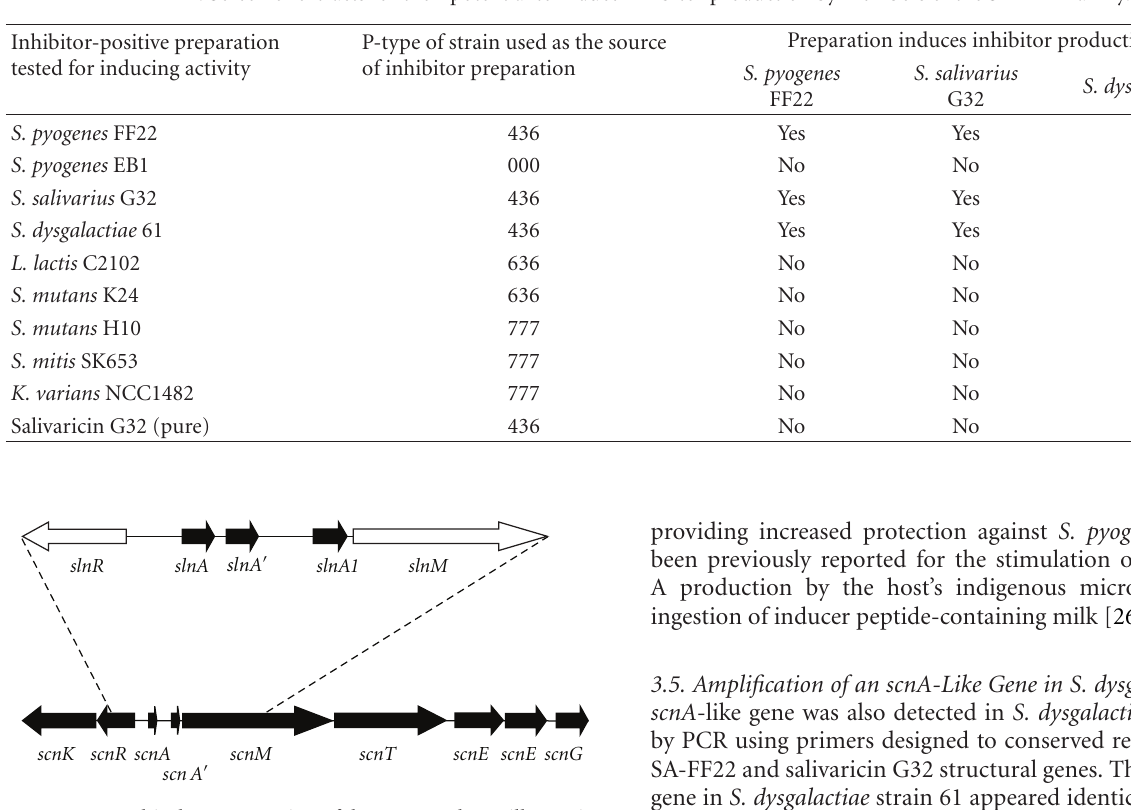
Figure 3: Graphical representation of the SA-FF22 locus illustrating the section of the salivaricin G32 locus that has been sequenced. Black-filled arrows indicate genes that have been completely sequenced. Unfilled arrows indicate genes for which the complete sequence has not yet been